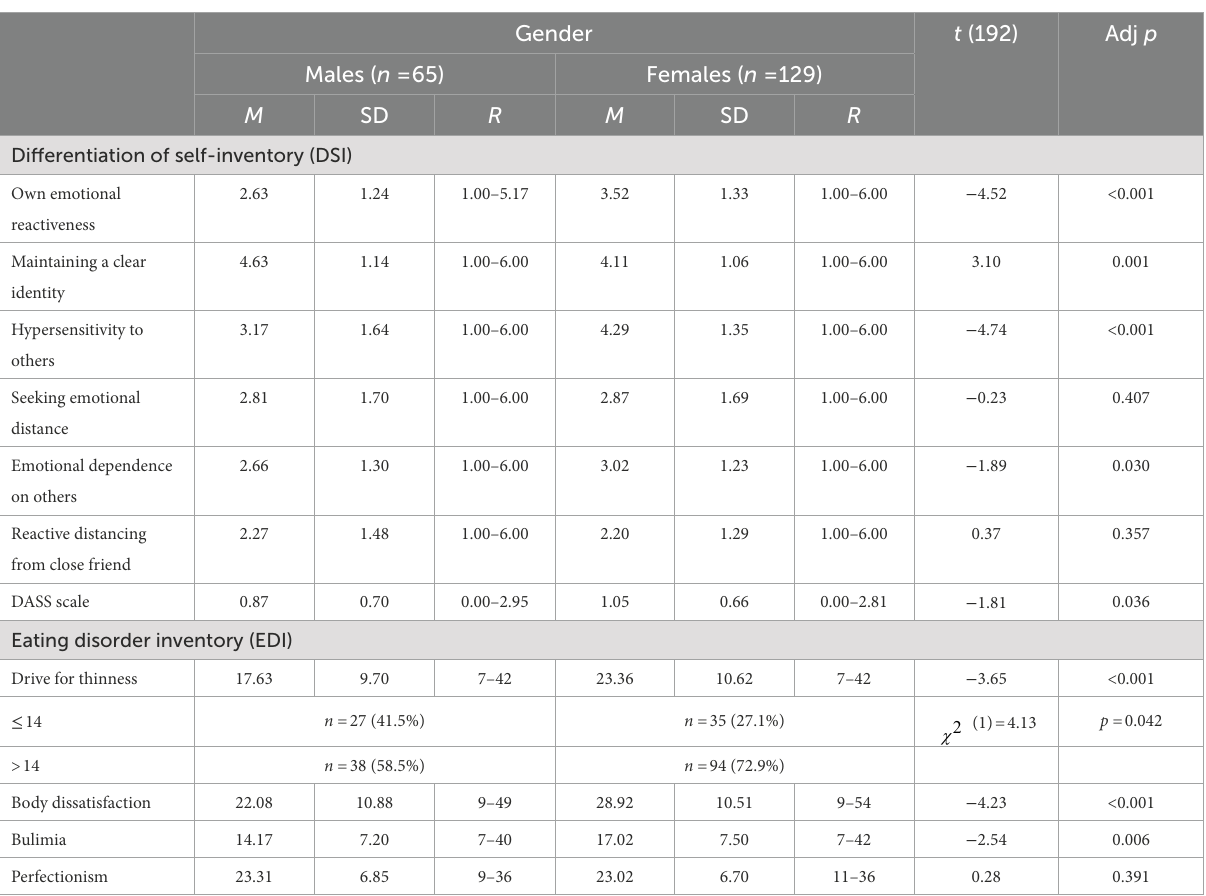
TABLE 2 Differences in the study variables by sex ( N =